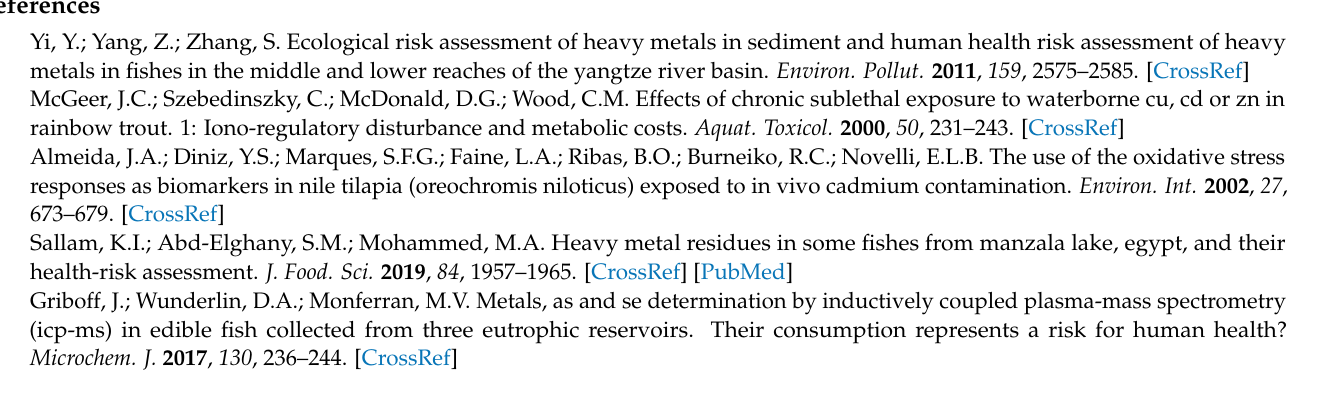
Table S3: Concentrations of heavy metals (mg kg − 1 dry weight) in abdominal muscles of crayfish collected from study sites in Hubei Province, Table S4: Estimated daily intake (EDI) for an adult/child of heavy metals in abdominal muscles of crayfish (ug kg − 1 day − 1